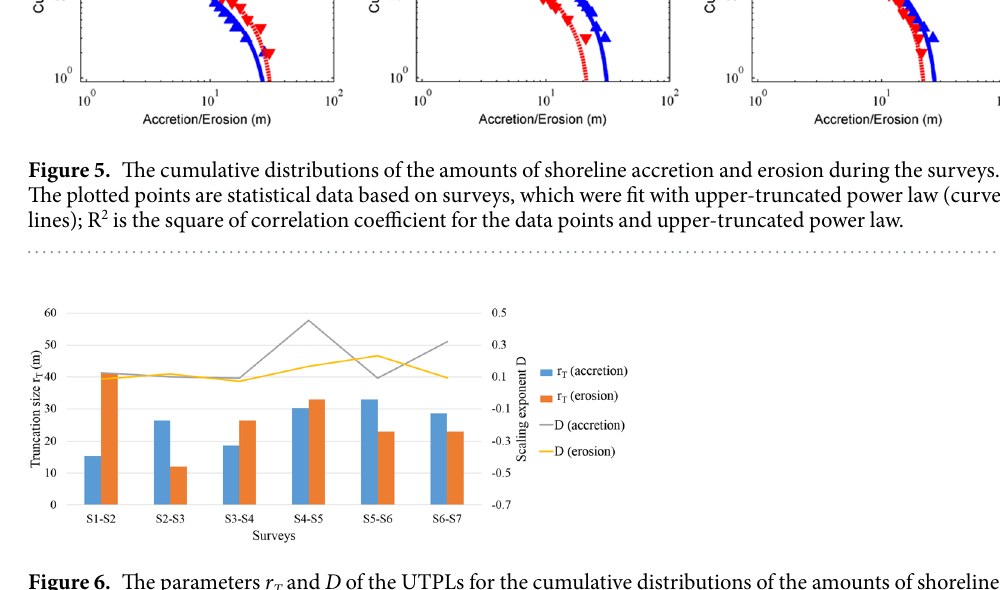
Figure 6. The parameters r T and D of the UTPLs for the cumulative distributions of the amounts of shoreline accretion and erosion during the